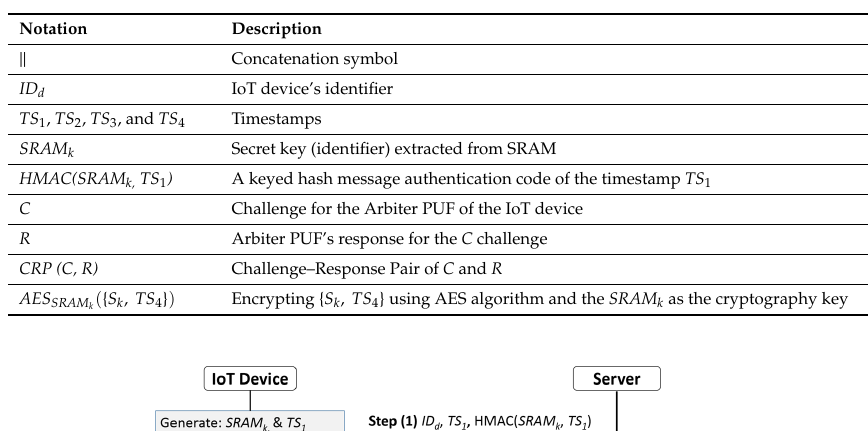
Table 1. Algorithm botation description.